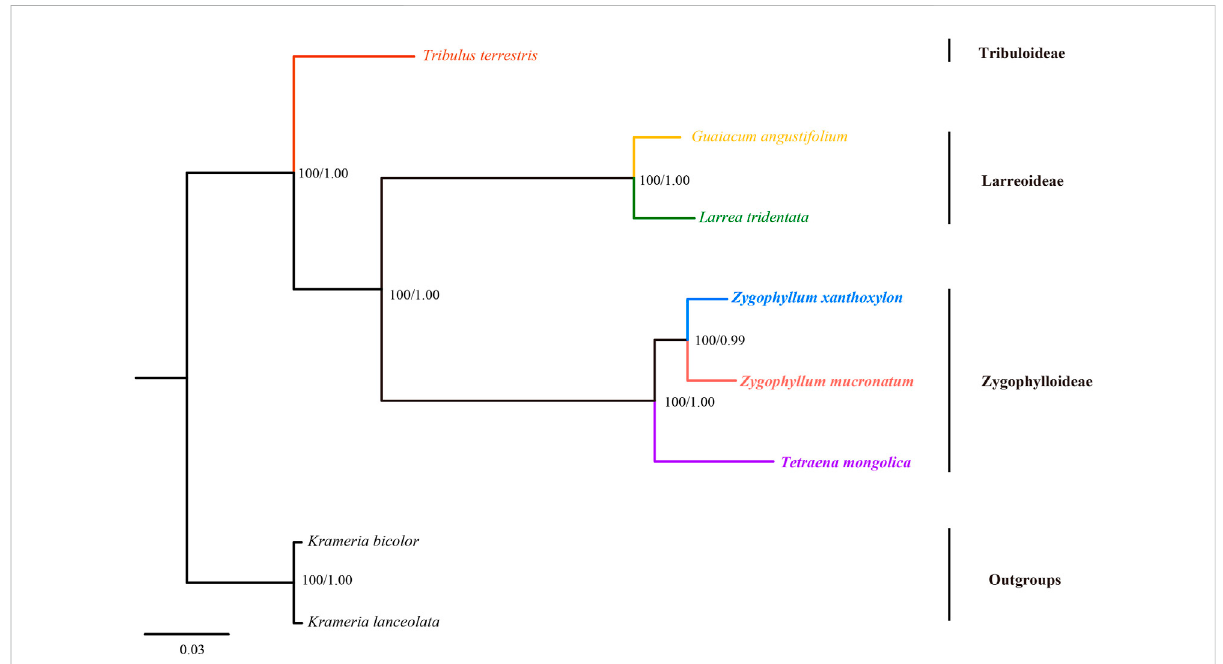
FIGURE 7 The ML tree of Zygophyllaceae inferred from complete cp genome dataset. Numbers at nodes represented the bootstrap support values and posterior probability values.